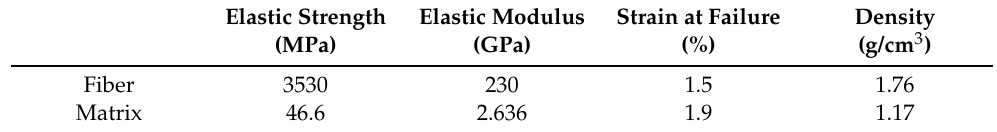
Table 1. Material properties of continuous carbon fiber and polylactic acid.